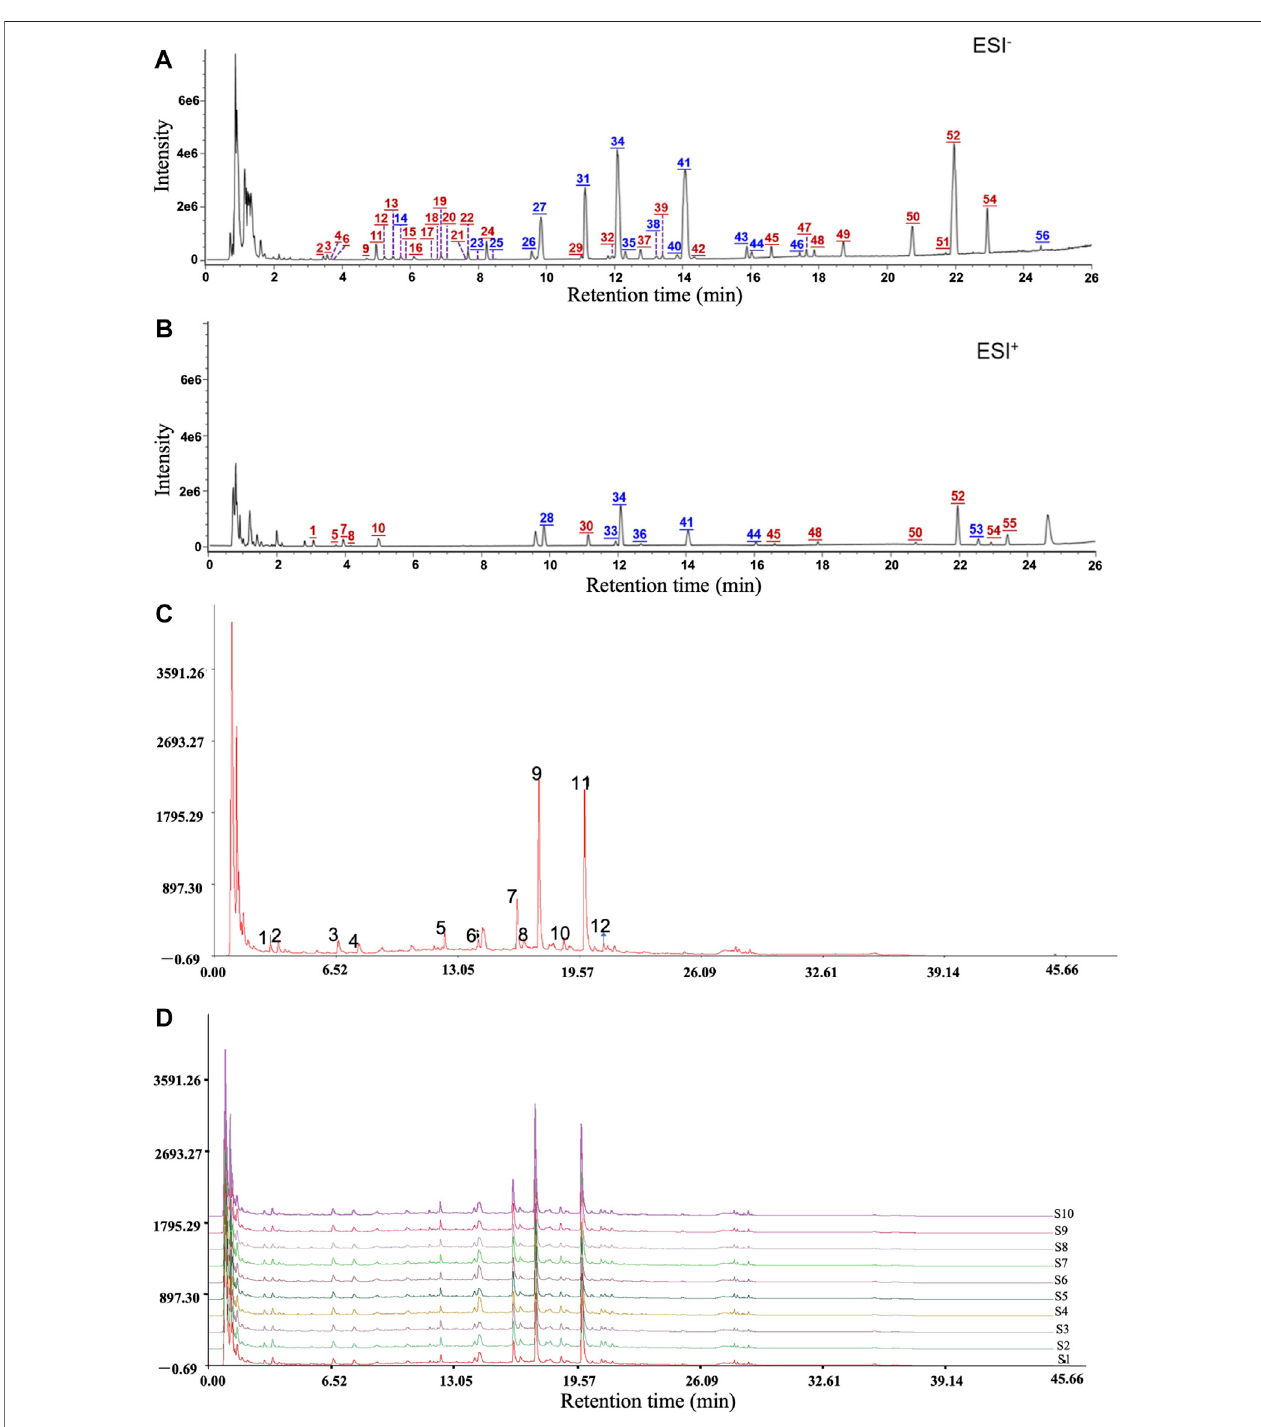
FIGURE1| Massspectrum chromatogramsofQMtoscreenforactive componentsandanalyzethereproducibility. (A) Negativeionmode. (B) Positive ionmode. Blue numbers represent those compounds that were identi fi ed through comparison with the reference standards. (C,D) The reproducible HPLC fi ngerprints of the mixture of 12 standard compounds and 10 batches of QM (S1 – S10), using the Chinese Medicine Chromatographic Fingerprint Similarity Evaluation System (2012 Edition). added (Solibol, Beijing, China). DMSO (150 μ l) was used to examine the effect of QM on the viability of TGF- β 1 – treated dissolve formazan crystals. Absorbance was measured at cells. After treatment for 24, 48, or 72 h, MTT (0.5 mg/ml) was 490 nm using a microplate reader. The cell survival rate